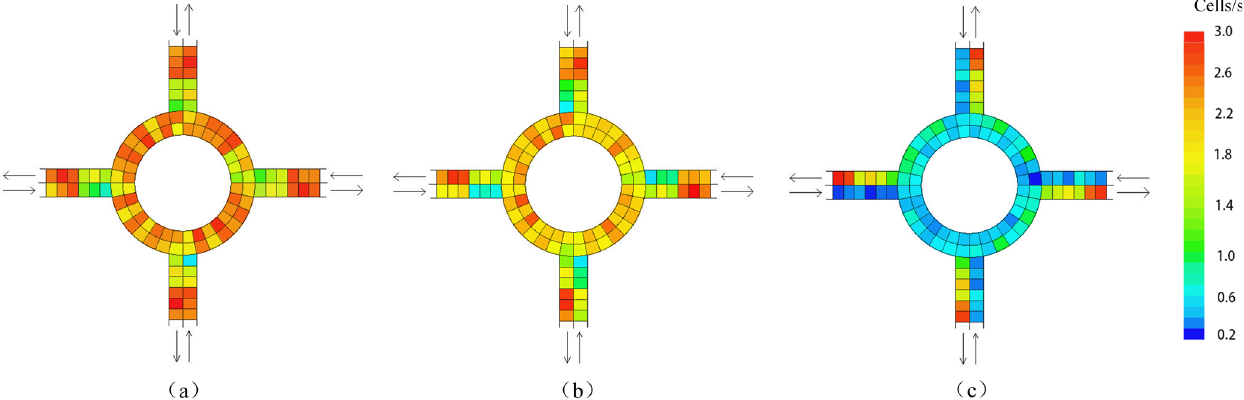
Figure 6. The average speed distribution of the cells at the roundabout obtained by simulation. (a) a = 0.01; (b) a = 0.05; (c) a =